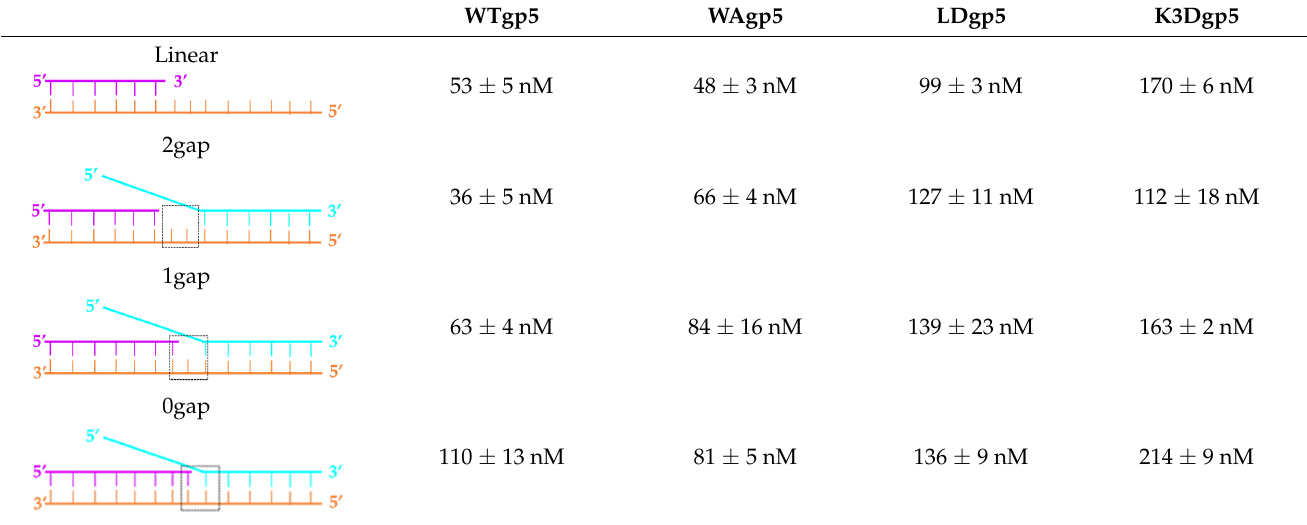
Figure 3. ( A ) Gel electrophoresis results of EMSA. ( B ) Quantification of the EMSA binding by fitting data to the Hill equation. Table 1. K d of WTgp5, WAgp5, LDgp5, and K3Dgp5, and DNA substrates with various gaps at the fork.